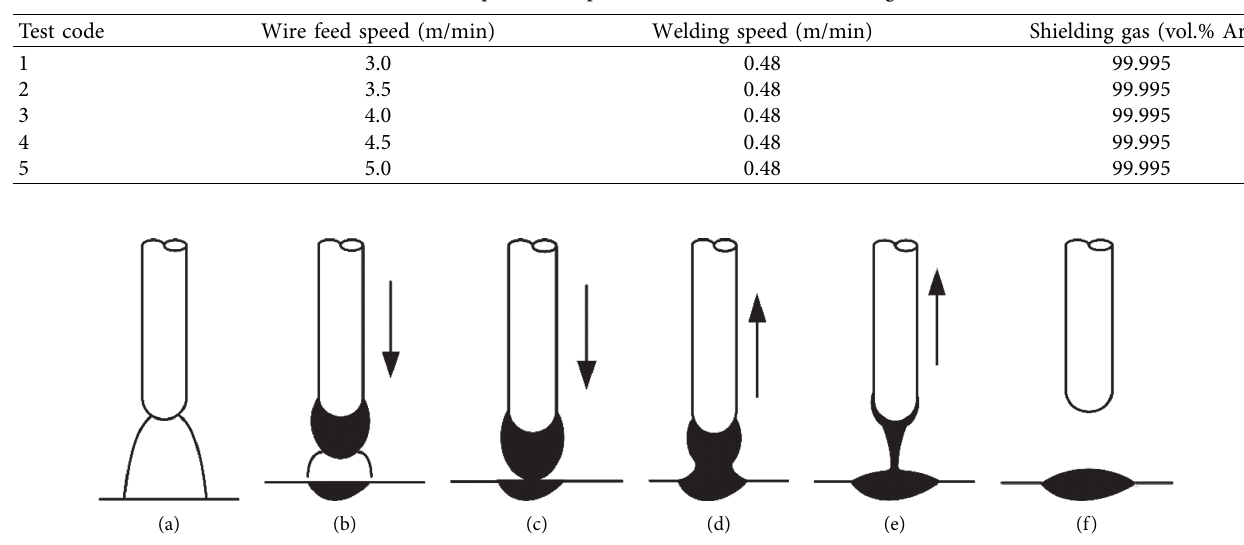
Table 1: Experimental parameters used in CMT welding.